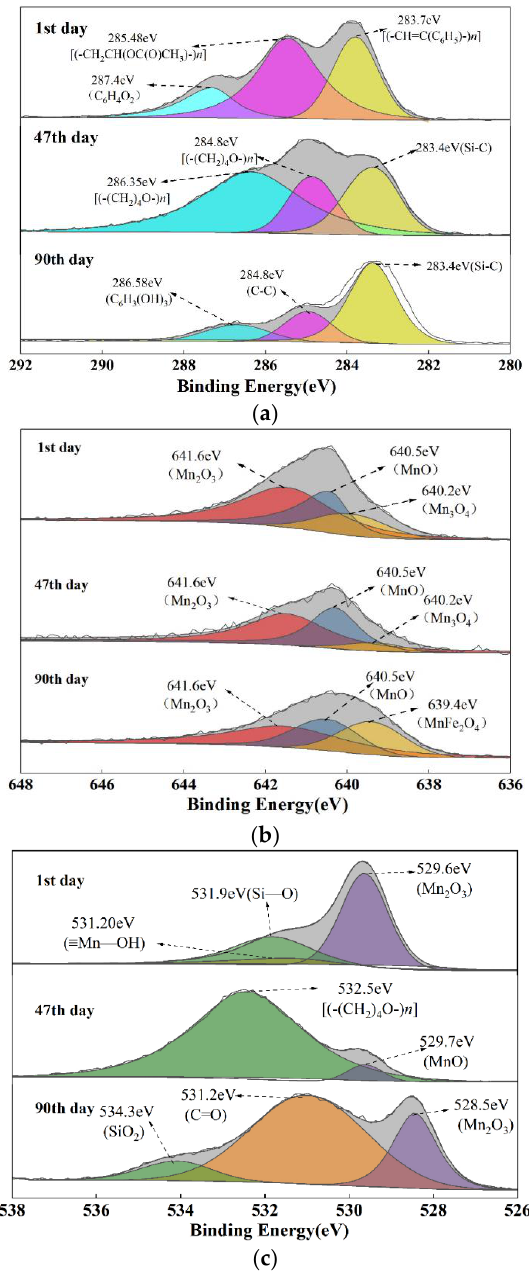
Figure 8. XPS energy spectra of ( a ) C1s, ( b ) Mn2p3/2 and ( c ) O1s with different experimental stages.